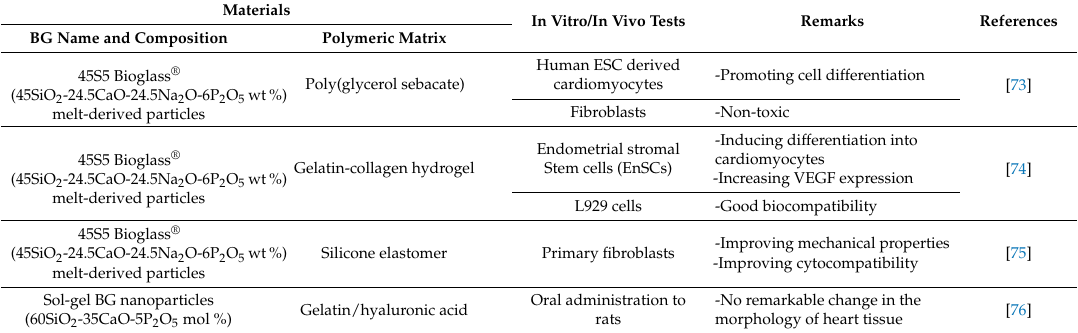
Table 2. Summary of the studies performed to evaluate the usability of BGs for heart tissue engineering.